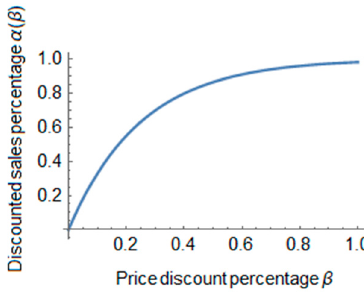
Figure 1. Discounted sales percentage plotted against the price discount percentage.